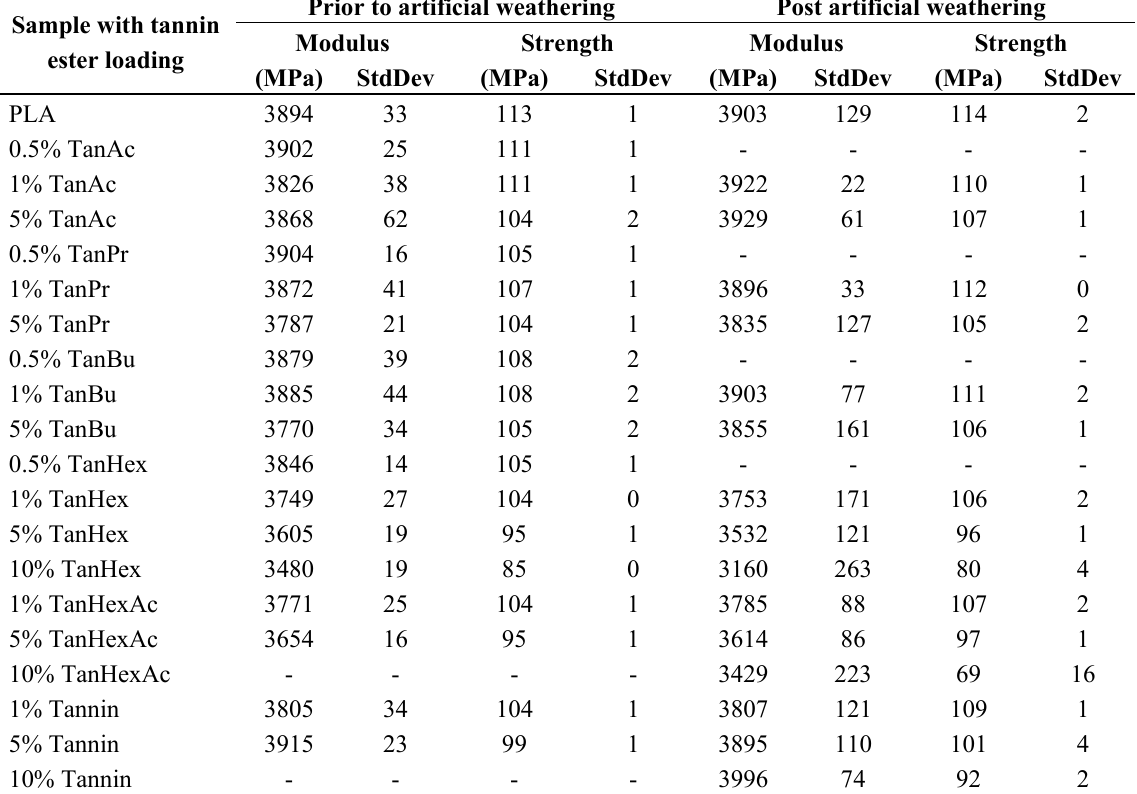
Table 4. Flexural testing results of modified PLA samples before and after artificial weathering. Sample with